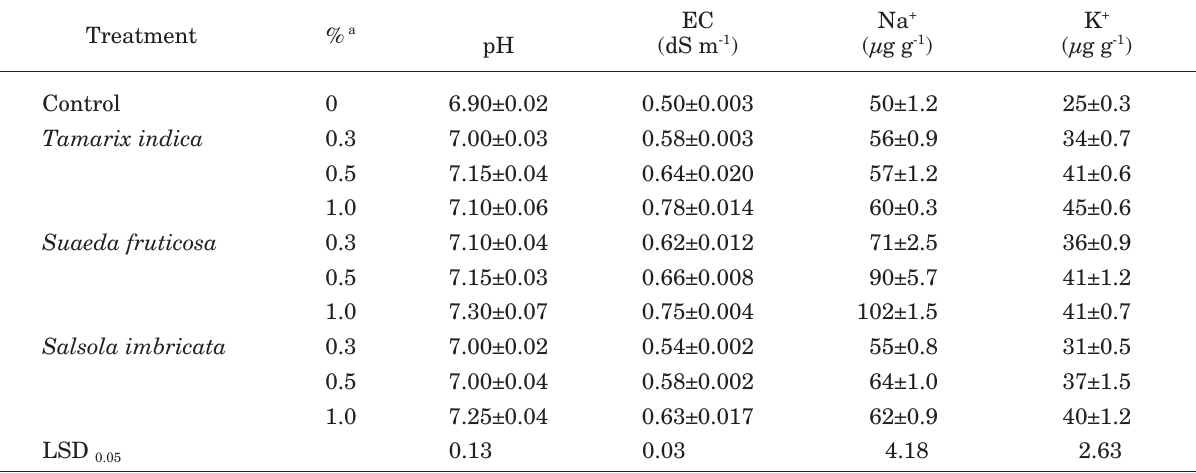
, Na + and K + ion concentration. e